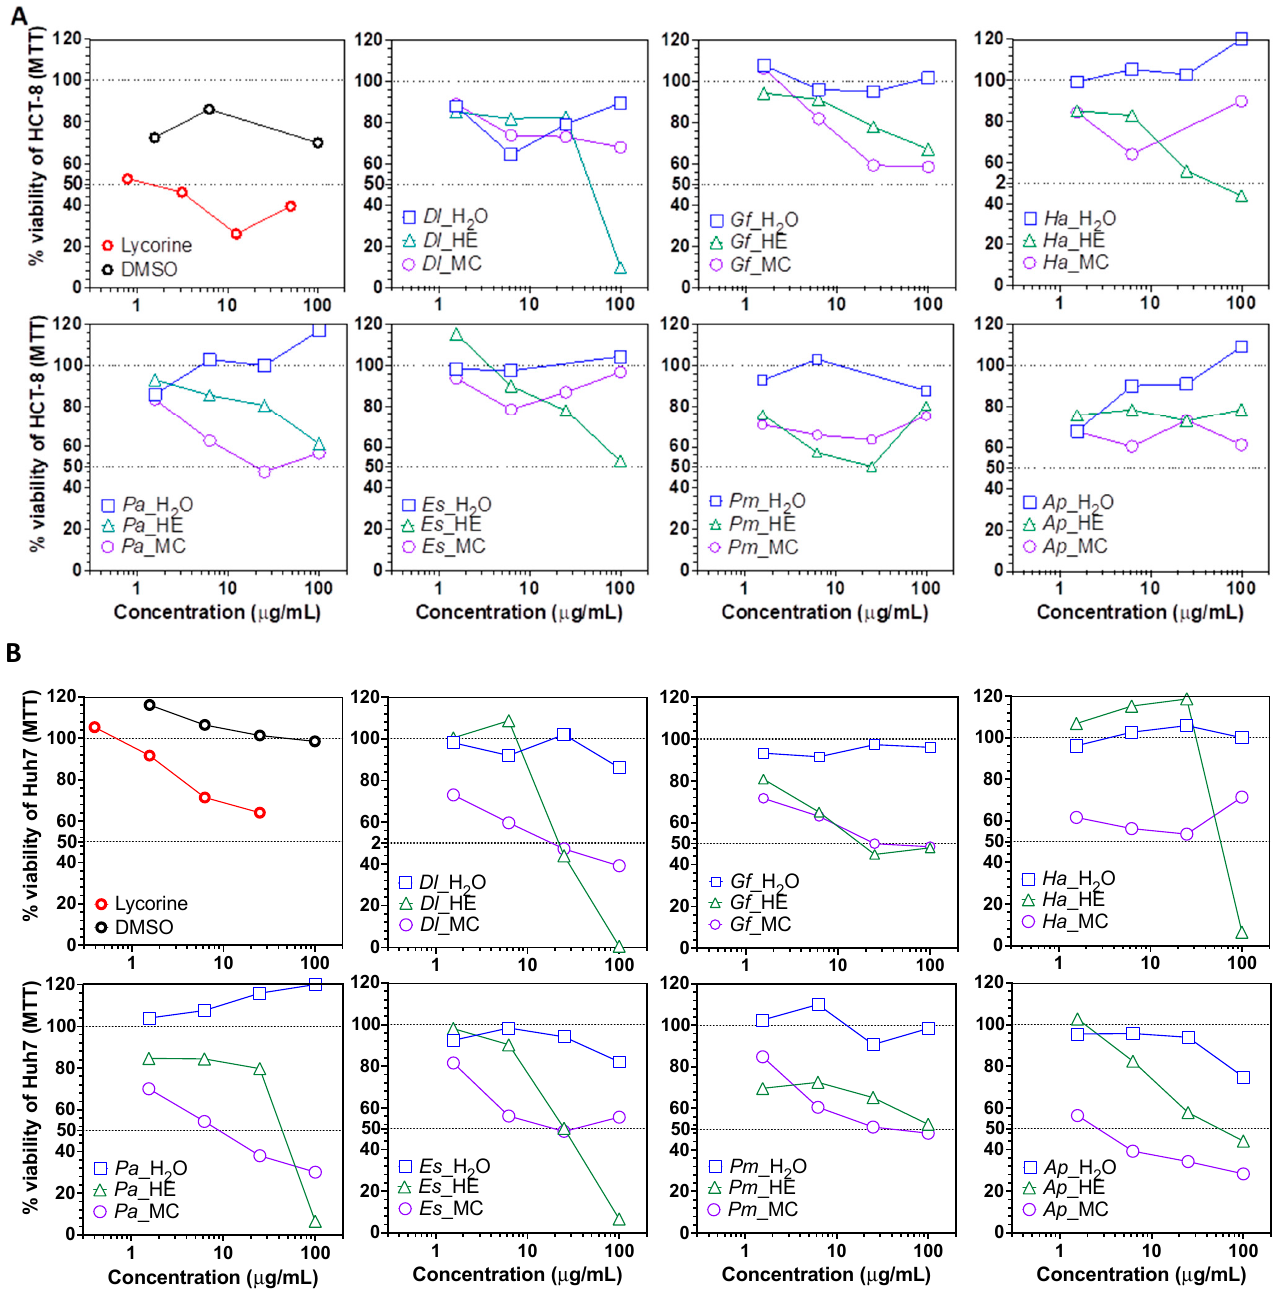
Figure 3. Cytotoxicity of plant extracts. ( A ) Viability of colorectal adenocarcinoma HCT-8 cells treated with plant extract fractions. ( B ) Viability of hepatocarcinoma Huh7 cells treated with plant extract fractions. Two dashed lines were added at CC 50 and CC 0 (100% of viability) to ease interpretation. Dl : Daucus lopadusanus ; Gf : Glaucium flavum ; Ha : Hypericum aegyptum ; Pa : Periploca angustifolia ; Es : Echinops spinosus ; Pm : Prasium majus ; Ap : Atriplex halimus ; H 2 O: H 2 O phase; HE: n -hexane extract MC: CH 2 Cl 2 extract; MTT: tetrazolium salt.